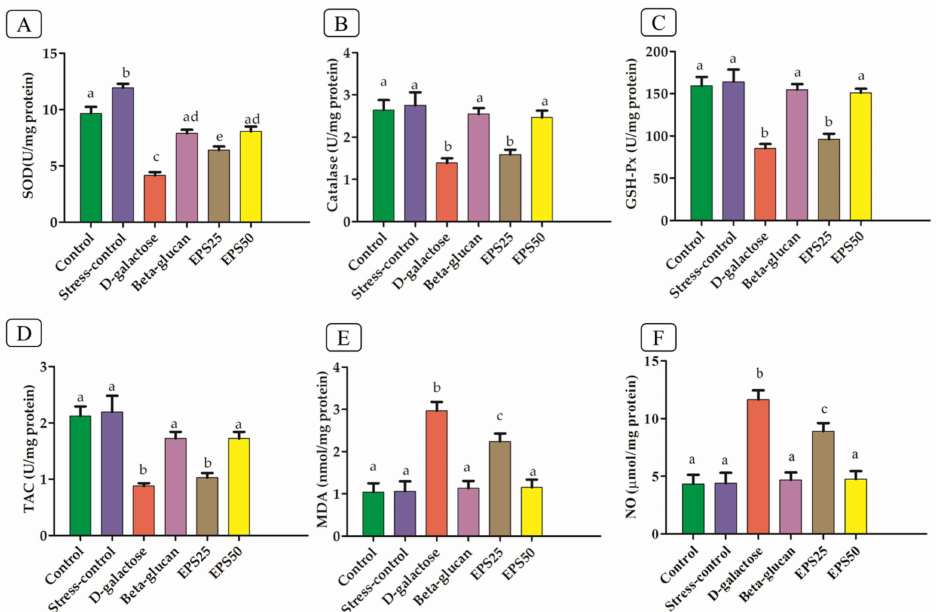
Figure 2. Effects of EPSRam12 on oxidative stress in the brain of D-galactose-induced mice. ( A ) Superoxide dismutase (SOD), ( B ) Catalase (CAT), ( C ) Glutathione peroxidase (GSH-Px), ( D ) Total antioxidant capacity (TAC), ( E ) Malonaldehyde (MDA), and ( F ) Nitric oxide (NO). Data are presented as mean ± SEM. Data were analyzed using One-way ANOVA with Bonferroni post-test. Values with dissimilar superscript alphabets (a–c) indicate significant differences ( p < 0.05) among the treatment